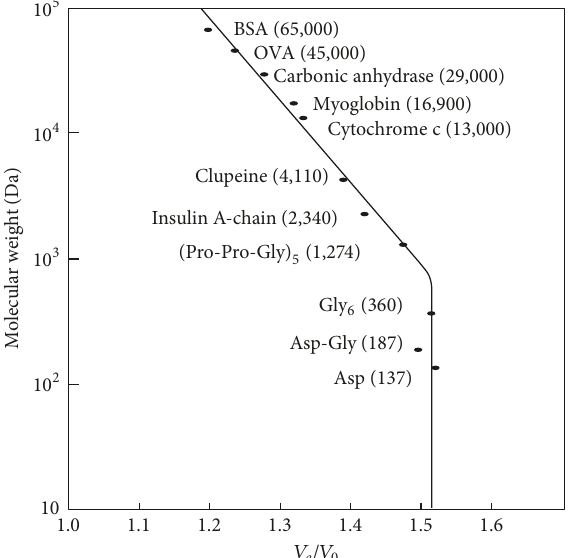
Figure 11: Calibration curve of the molecular weight of peptides using HPLC with a TSK-GEL G-3000PW (300mm × 7.5mm i.d.). Eluent: 0.1M sodium phosphate buffer, pH 6.9; flow rate: 0.7 mL/min; detection: UV 230 nm. 𝑉 𝑒 : volume (mL) of elution for each sample; 𝑉 0 : elution volume of blue dextran as void volume